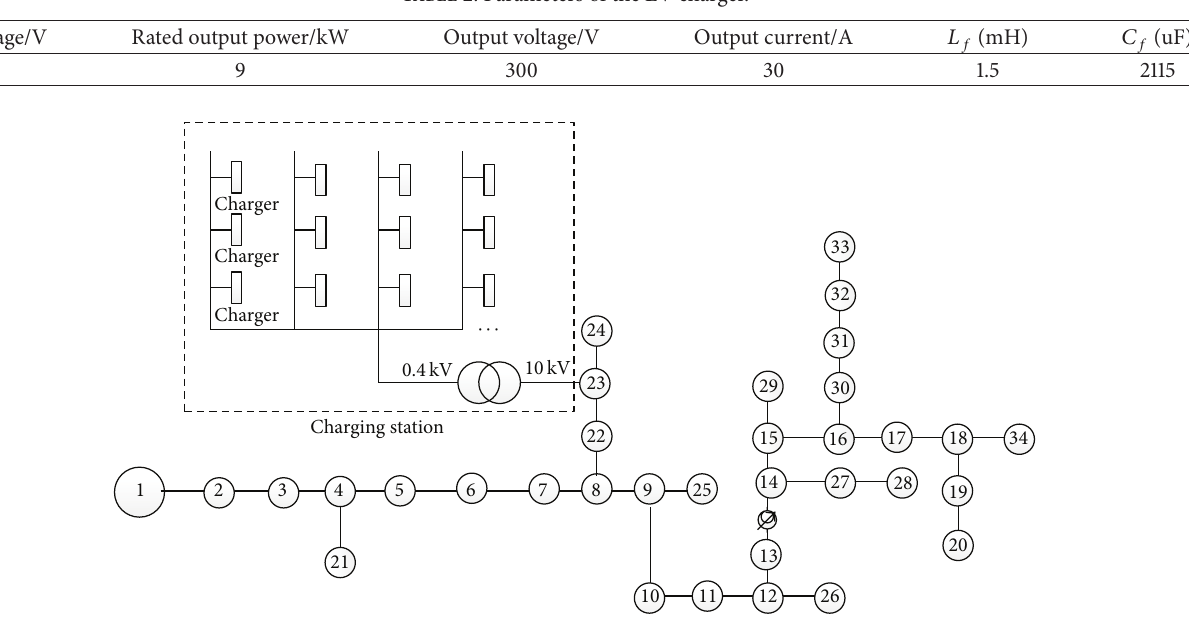
Figure 7: The diagram of the modified IEEE-34 test system.